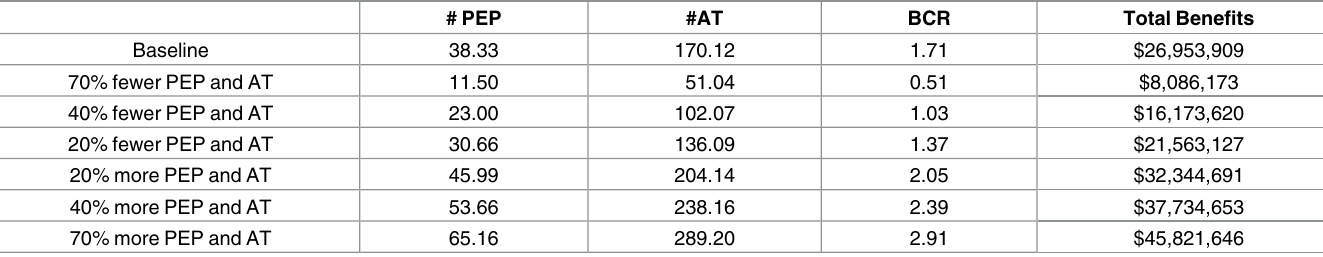
Table 5. Total benefits and BCRs resulting from adjusting estimated PEP and AT rates.